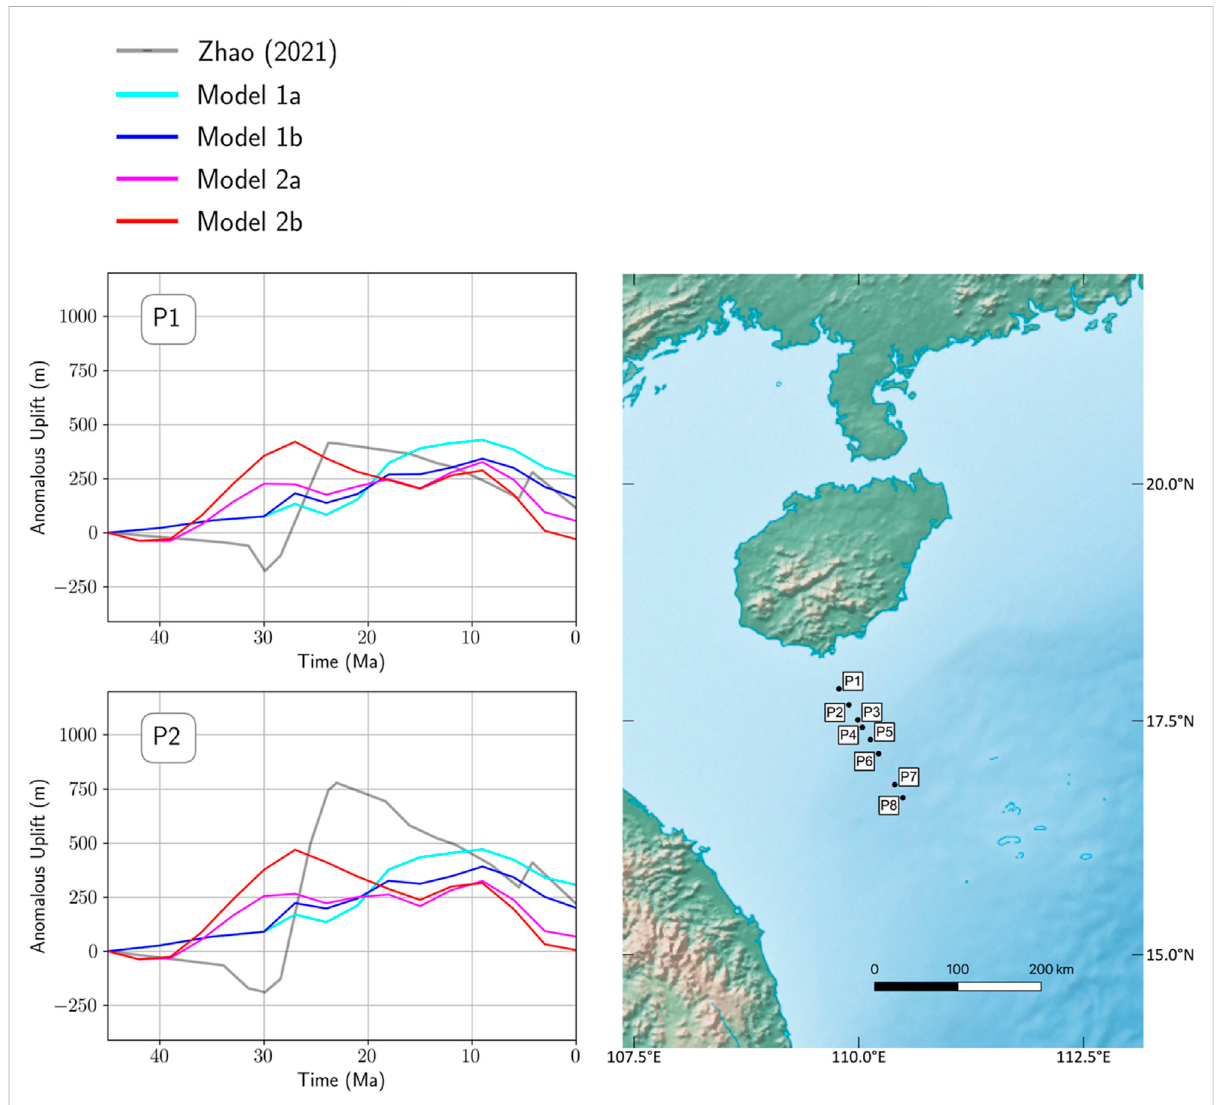
FIGURE 8 ComparisonbetweentheanomalousupliftoftheQDNBfromZhao(2021)since45 Mawiththepredictedchangeofdynamictopographysince this time predicted by the mantle circulation models of Lin et al.